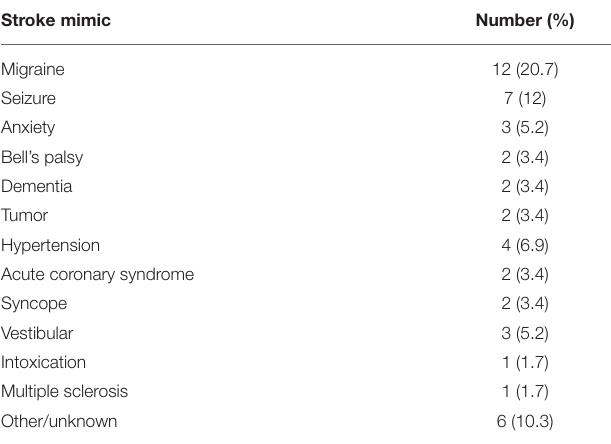
TABLE 1 | Stroke mimic